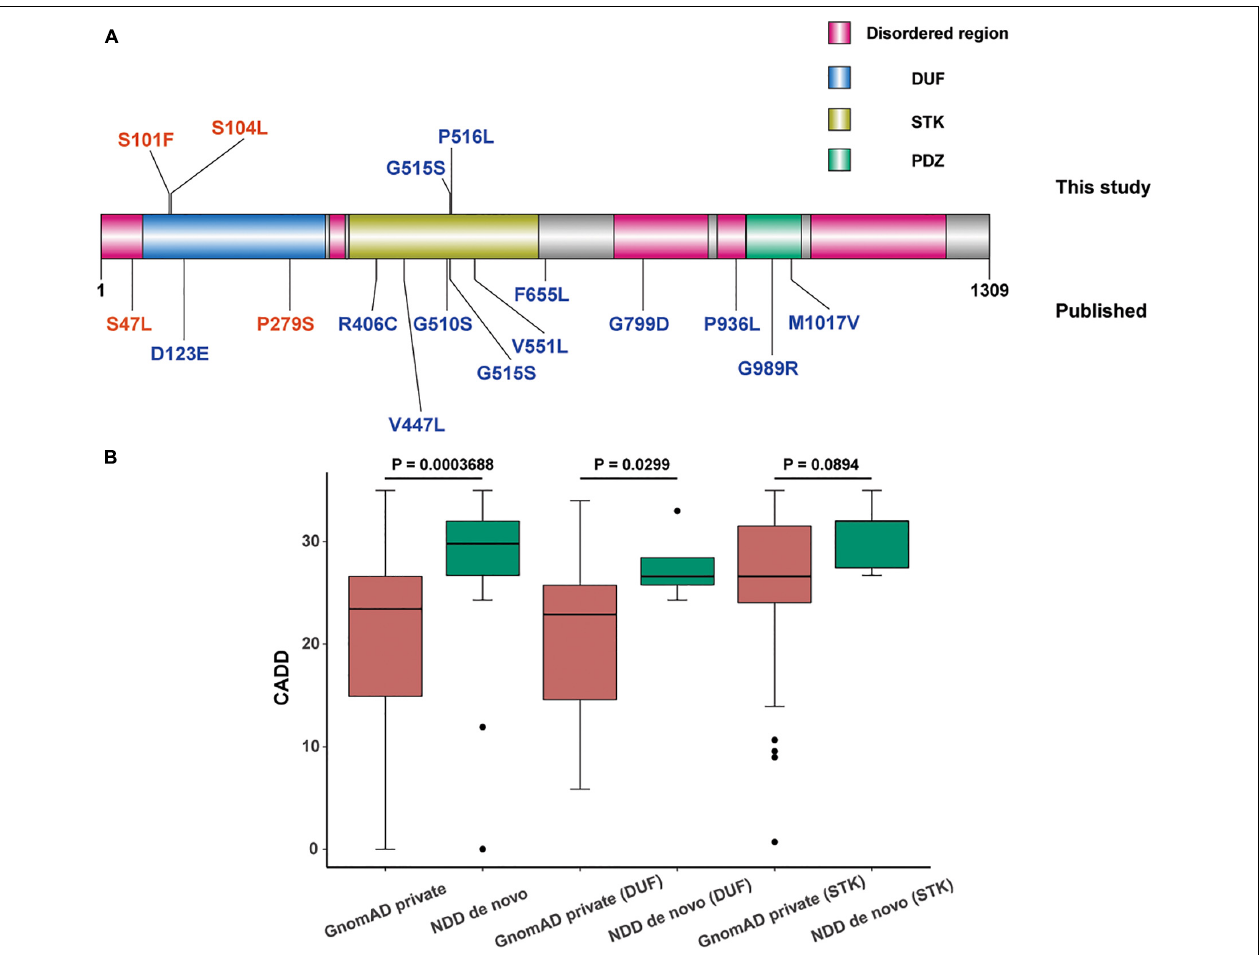
FIGURE 2 | Distribution and comparison of pathogenicity of missense mutations in domain of unknown function (DUF) and serine-threonine kinas (STK) domain of microtubule associated serine/threonine kinase 3 ( MAST3 ). (A) Schematic representation of missense variations in MAST3 . Variations above and under the protein domain graph are originated from this study and published research, respectively. The colors in the MAST3 protein represented different protein domains (pink: disordered region, blue: DUF domain, yellow: STK domain, and green: PDZ domain). The different colors of the variants showed different diseases (red, ASD; blue, DD). (B) Box plot of CADD of de novo (neurodevelopmental diseases, NDD)/private (GnomAD) missense mutations in DUF or STK domain. Higher CADD scores of missense variants in total and in DUF region of MAST3 were found in NDD cohort compared with that in gnomAD database ( p = 0.0003688, 0.0229, Wilcoxon test). Significance was lost when the same analysis was performed for STK domain variants ( p = 0.0894, Wilcoxon